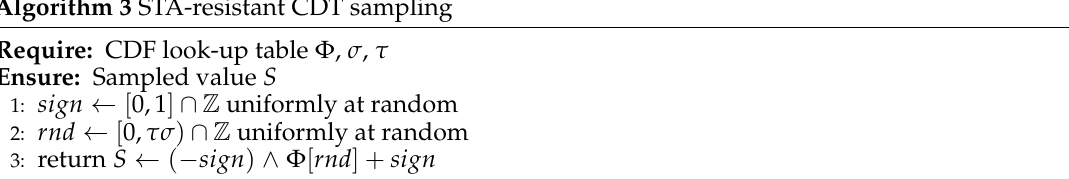
Algorithm 3 STA-resistant CDT sampling